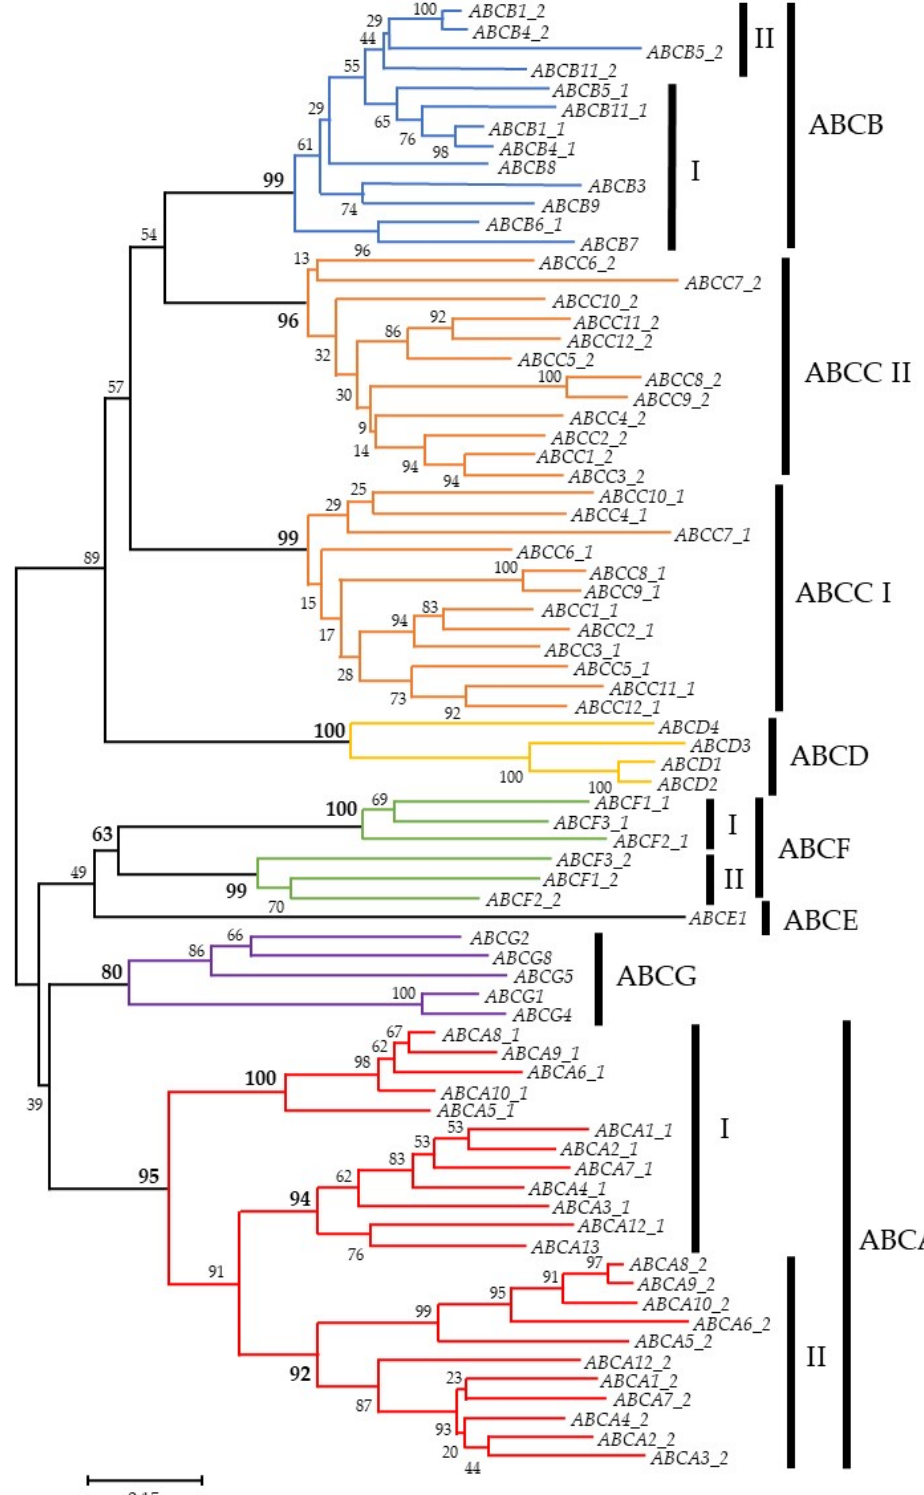
Figure 1. Phylogenetic tree of the human ATP-Binding Cassette (ABC) genes. The alignments are based on data from reference [19]. Some of the analysed proteins contain two ATP-binding domains (I and II), whereas others contain only one ATP-binding domain. The number at the branch of the nodes represents the value from 100 replications.